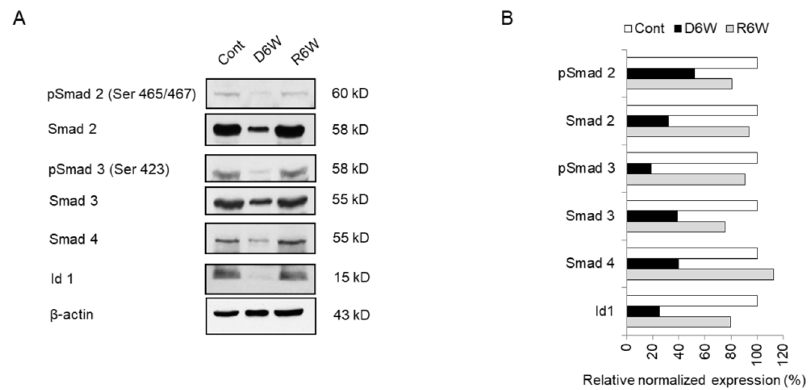
Figure 8. Analysis of miRNA target genes expression in cuprizone-fed mice and control mice. ( A ) Western blot analysis shows the phosphorylated and total Smad 2, Smad 3, Smad 4, and Id1 in demyelinated mice (D6W) and remyelinated mice (R6W) compared to control mice (Cont). n = 2. ( B ) The graph shows the relative normalized expression of these in D6W and R6W with Cont. The uncut original western blot images are in Supplementary Figure S2.